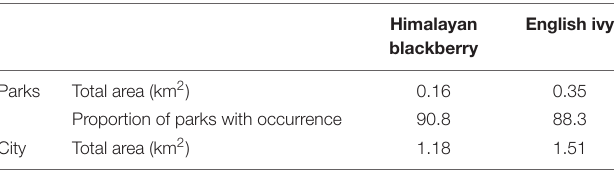
TABLE 4 | Total area covered across the parks system and the city, and number of parks and 10 m by 10 m cells covered by English ivy ( Hedera helix ) and Himalayan blackberry ( Rubus armeniacus ) in Surrey, BC, Canada.